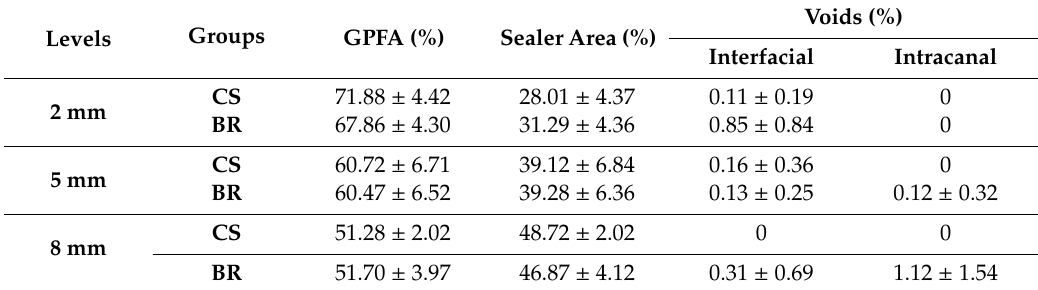
Table 2. Gutta-percha filling area (GPFA), sealer area, and void (interfacial and intracanal voids) percentages in the samples at 2, 5, and 8 mm from the working length.